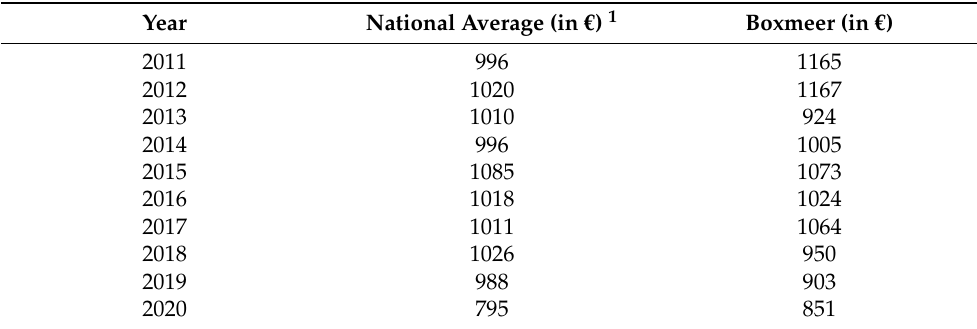
Table 4. Average educational expenses per staff member (source: https://www.aeno.nl accessed on 21 June